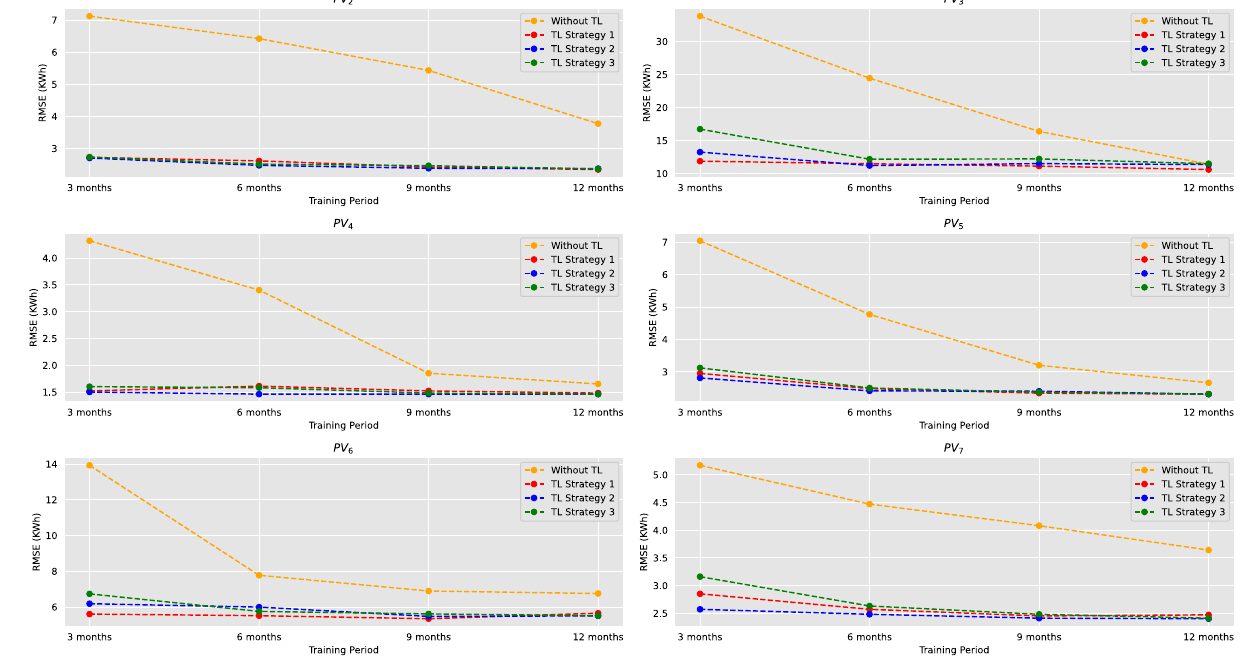
Figure 7. Comparative performance of the four models based on RMSE index for 3 month, 6 month, 9 month and 12 month training period for the six target domain